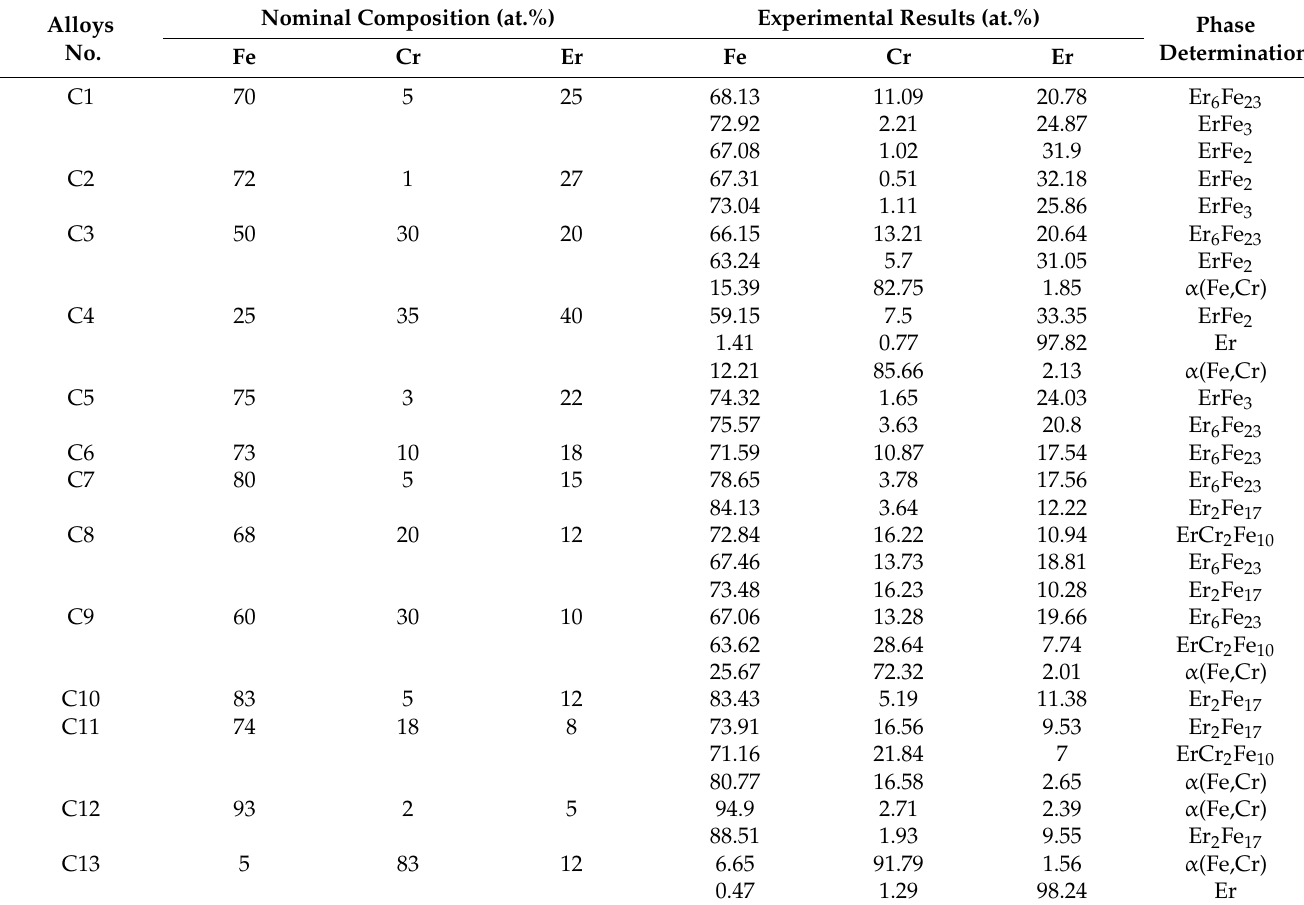
Table 4. Constituent phases and compositions in the annealed Fe–Cr–Er alloys at 973 K for 90 days. Nominal Composition (at.%) Experimental Results (at.%) Alloys No.